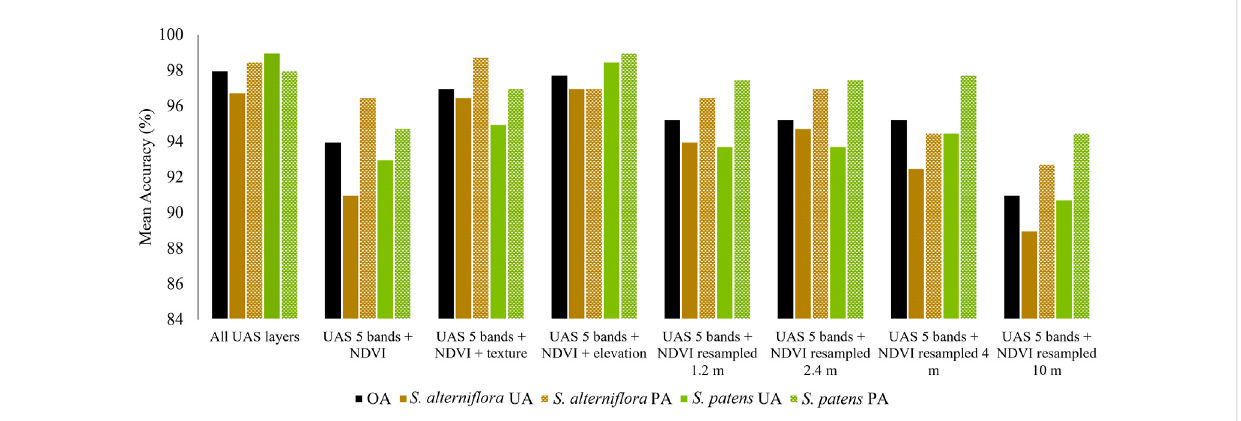
FIGURE 6 Bar plot of random forest classi fi cation accuracies (%) averaged across datasets when applied to various combinations of raster layers. OA = Overall accuracy, UA = User ’ s accuracy, PA = Producer ’ s accuracy.